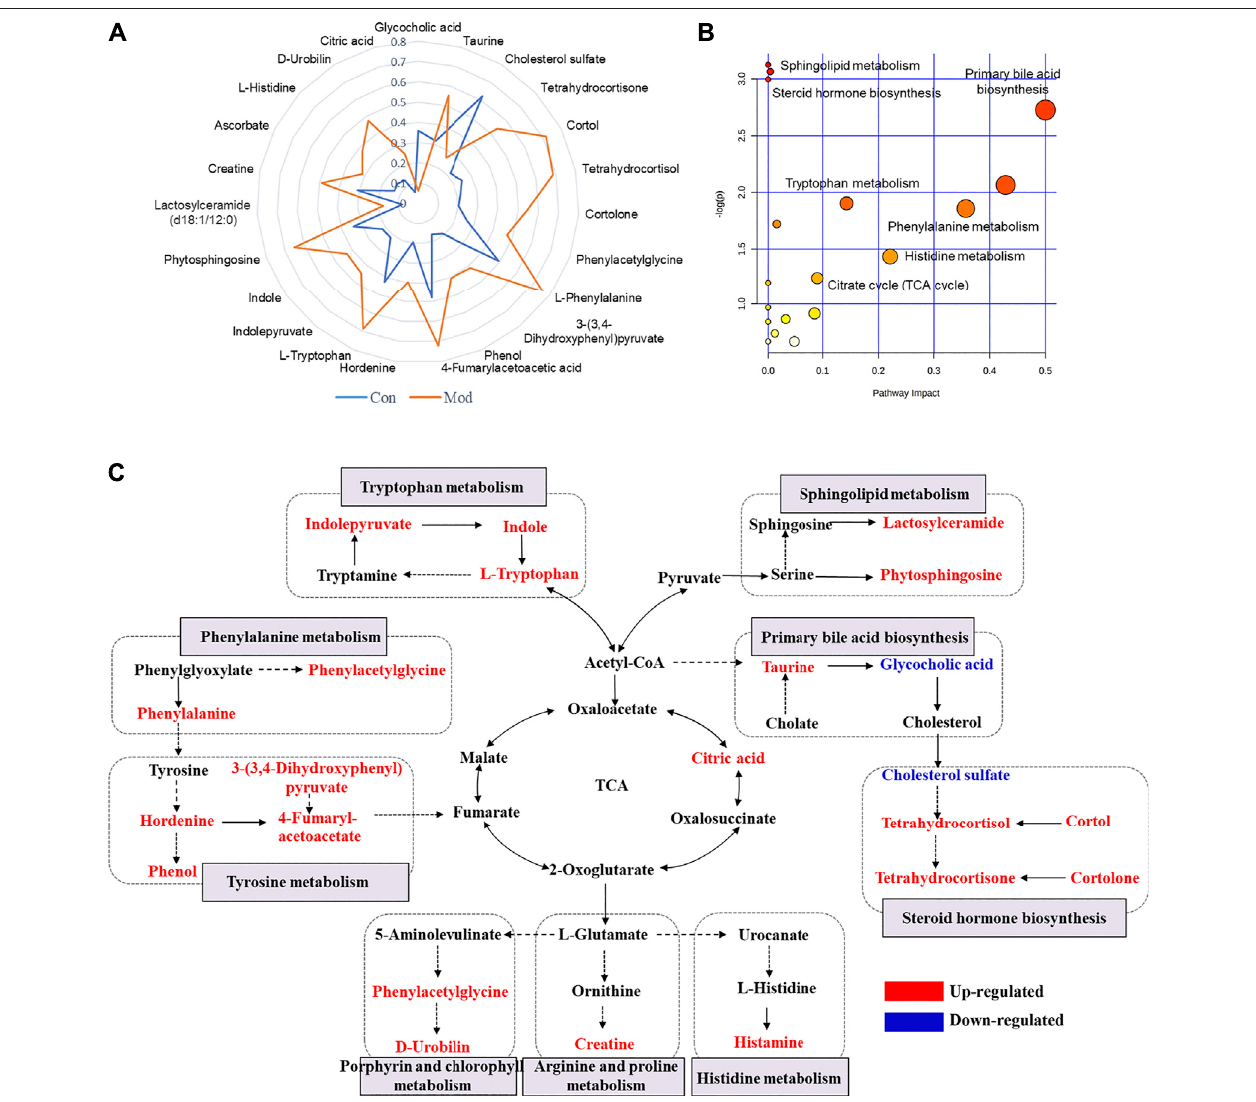
FIGURE 4 | Pro fi le of susceptibility-related metabolomic biomarkers of Dicl-IDILI. (A) The relative abundance radar plot of 23 metabolites. The blue line represents the control group (Con), and the orange line represents the susceptibility model group (Mod). (B) The bubble diagram of the disturbed metabolic pathways. (C) The networkmapofmetabolicpathwaysandmetabolites.Metabolitesinredorblueindicateup-ordownregulatedexpressions,respectively,intheModgroupcomparedto the control group.